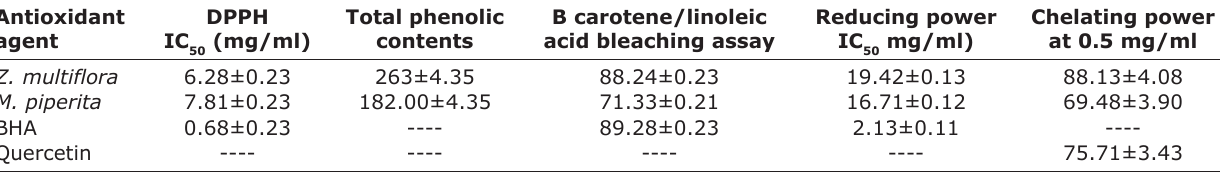
Table-1: Antioxidant potential of ZEO and MEOs using common antioxidant assays. Antioxidant